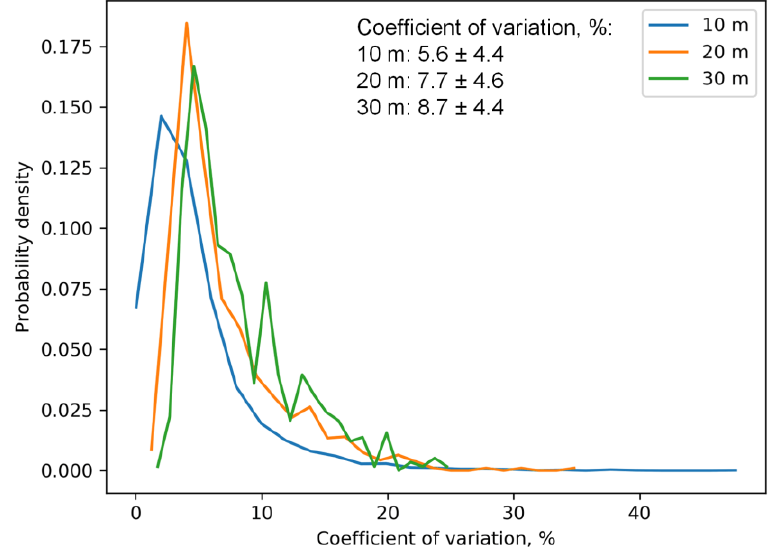
Figure 6. Histogram of coefficient of variation of yields inside a moderate spatial resolution pixel (10, 20, and 30 m).